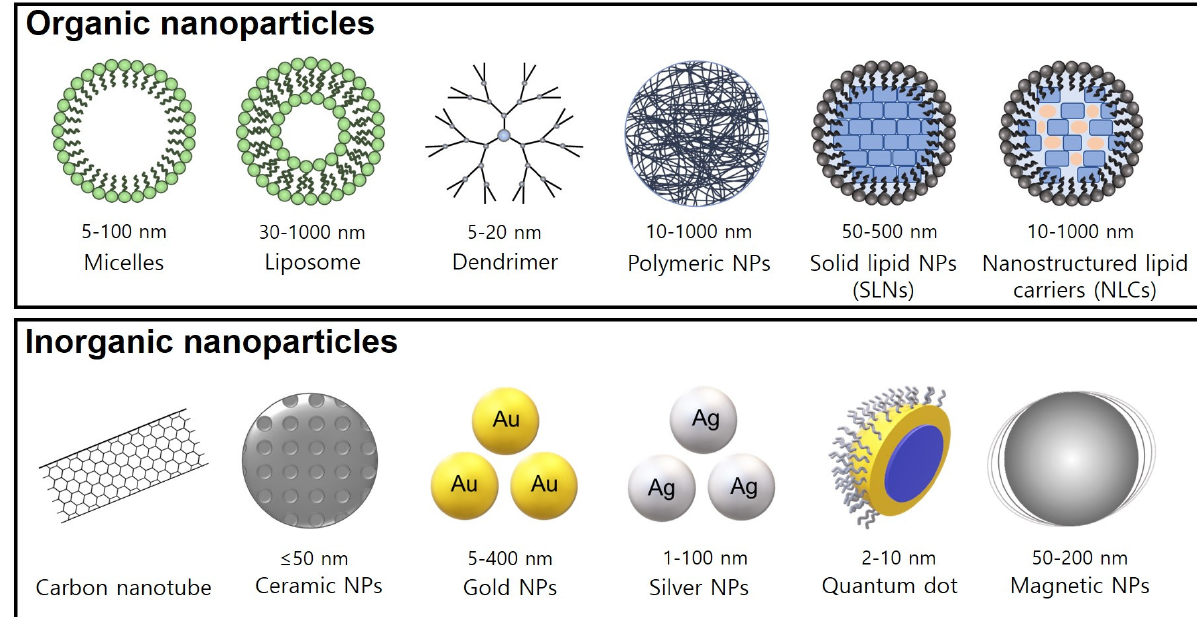
Figure 2. Morphology and size of nanostructured NPs. The physicochemical properties of these NPs include biocompatibility, biodegradability, and controlled/targeted drug release.